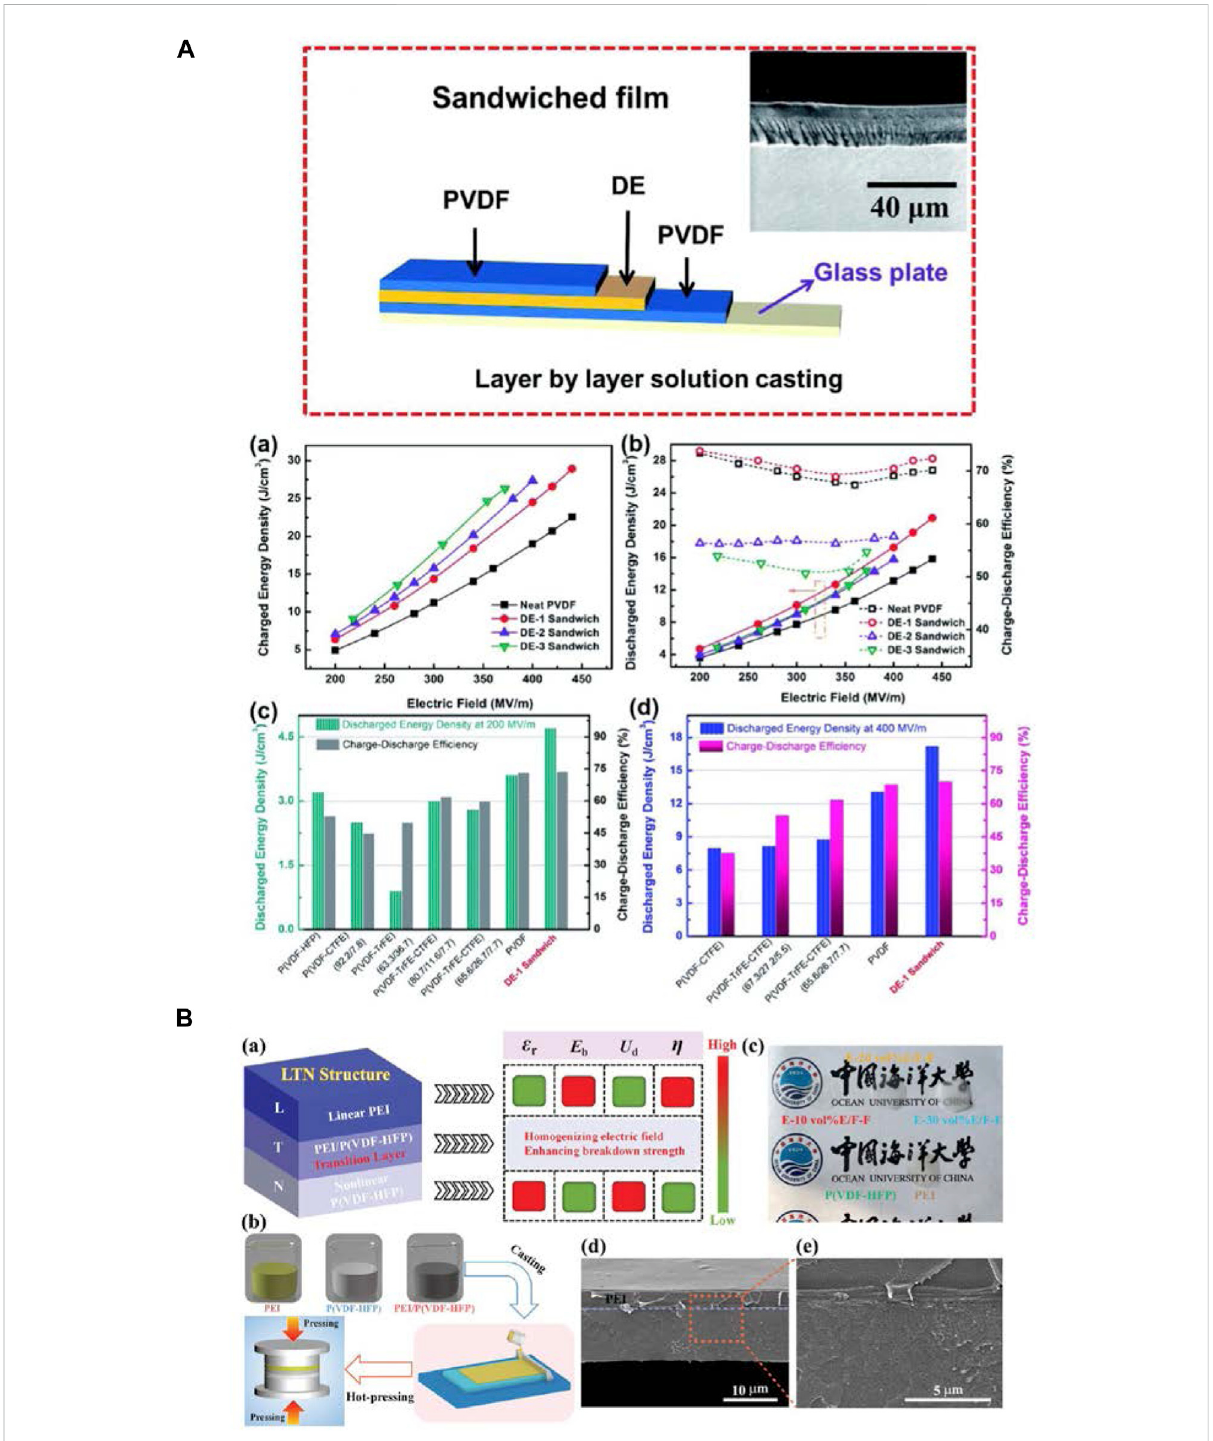
FIGURE 10 (A) Schematicillustrationofthesandwich-structured fi lmsthroughthelayer-by-layersolutioncastingmethod,and(a)Chargedenergydensity, (b) Discharged energy density and charge-discharge ef fi ciency of pristine PVDF and the sandwich-structured polymer fi lms as a function of the applied fi eld, Comparison of the discharged density and charge-discharge ef fi ciency of the DE-1 sandwich polymer fi lm at (c) 200 MV/m and (d) 400 MV/m with PVDF and its copolymer and terpolymer fi lms. (B) (a) Schematic illustration of the dielectric energy-storage characteristics of the asymmetric LTN structure; (b) Fabrication process of the single-layer and trilayer composites; (c) Photograph of pure PEI, pure P(VDF-HFP), and trilayer composites; (d,e) Cross-sectional SEM morphology of E-10 vol%E/F-F trilayer composite. Reproduced with permission from Ref. 91 and 97. Copyright 2018 and 2021 The Royal Society of Chemistry, and